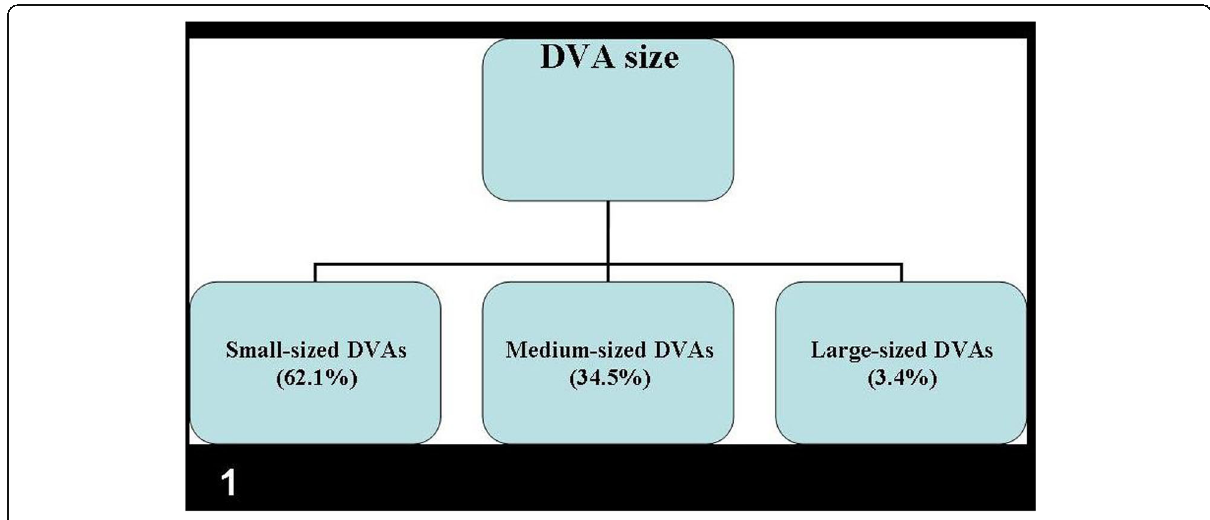
Fig. 1 Prevalence of developmental venous anomalies by